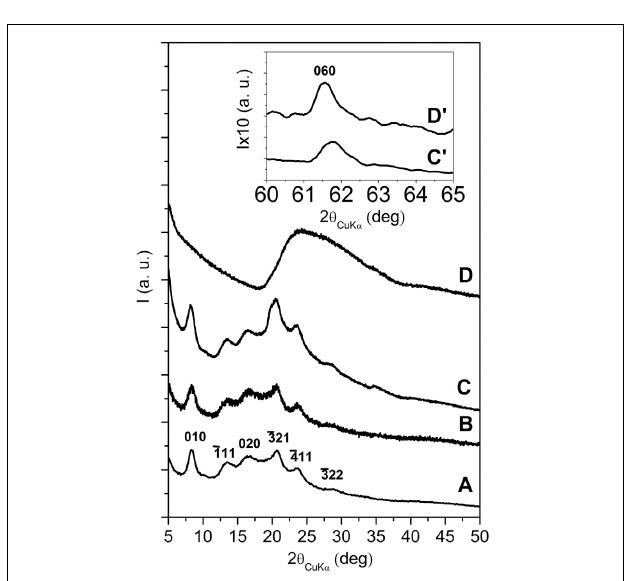
FIGURE 5 | X-ray diffraction (CuK α ) patterns in the 2 ϑ range 5–50 ◦ of s-PS aerogels with exfoliated OMMT, as obtained from gels with a solvent content of 90 wt % and presenting different polymer/OMMT weight ratios: (A) 100/0; (B) 95/5; (C) 80/20; (D) 50/50. The inset C (cid:4) , D (cid:4) enlarges the 060 in-plane reflection of the